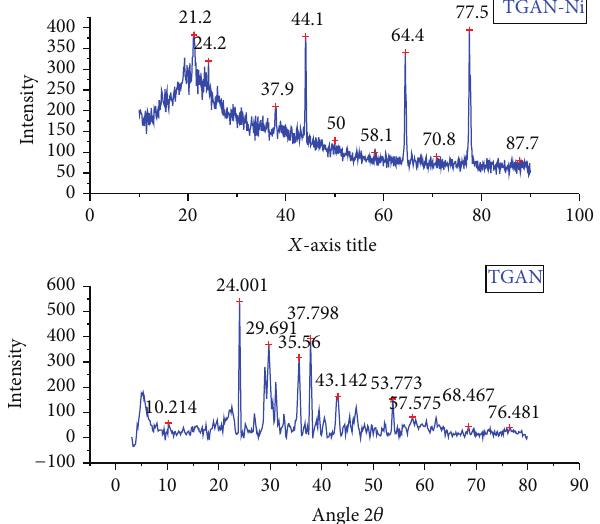
Figure 1: XRD analysis of TGAN and TGAN-Ni.